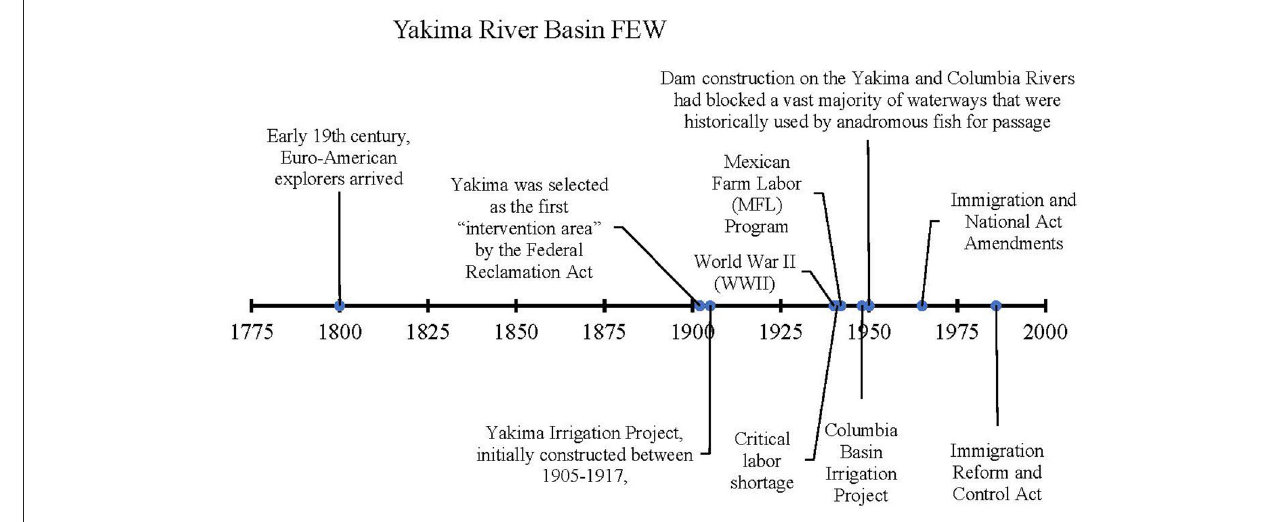
FIGURE 2 | Development of Yakima River Basin FEW